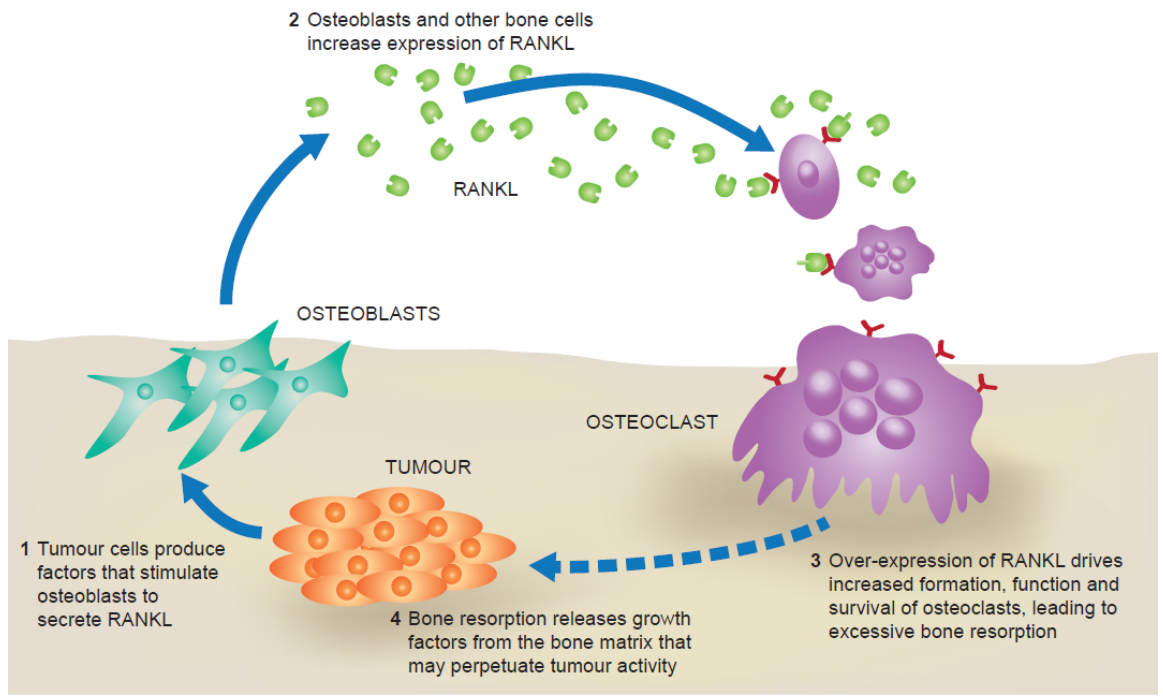
Figure 1. The “vicious cycle” of bone destruction in metastatic bone